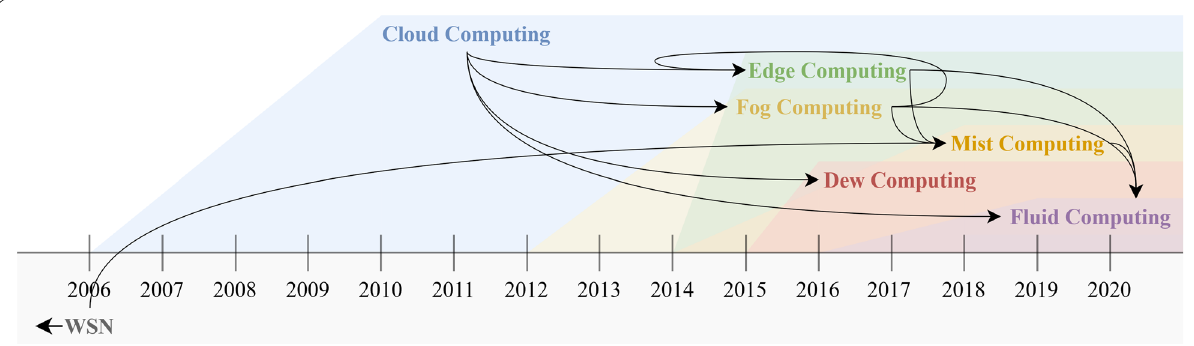
Fig. 1 Evolution of Cloud and post‑Cloud